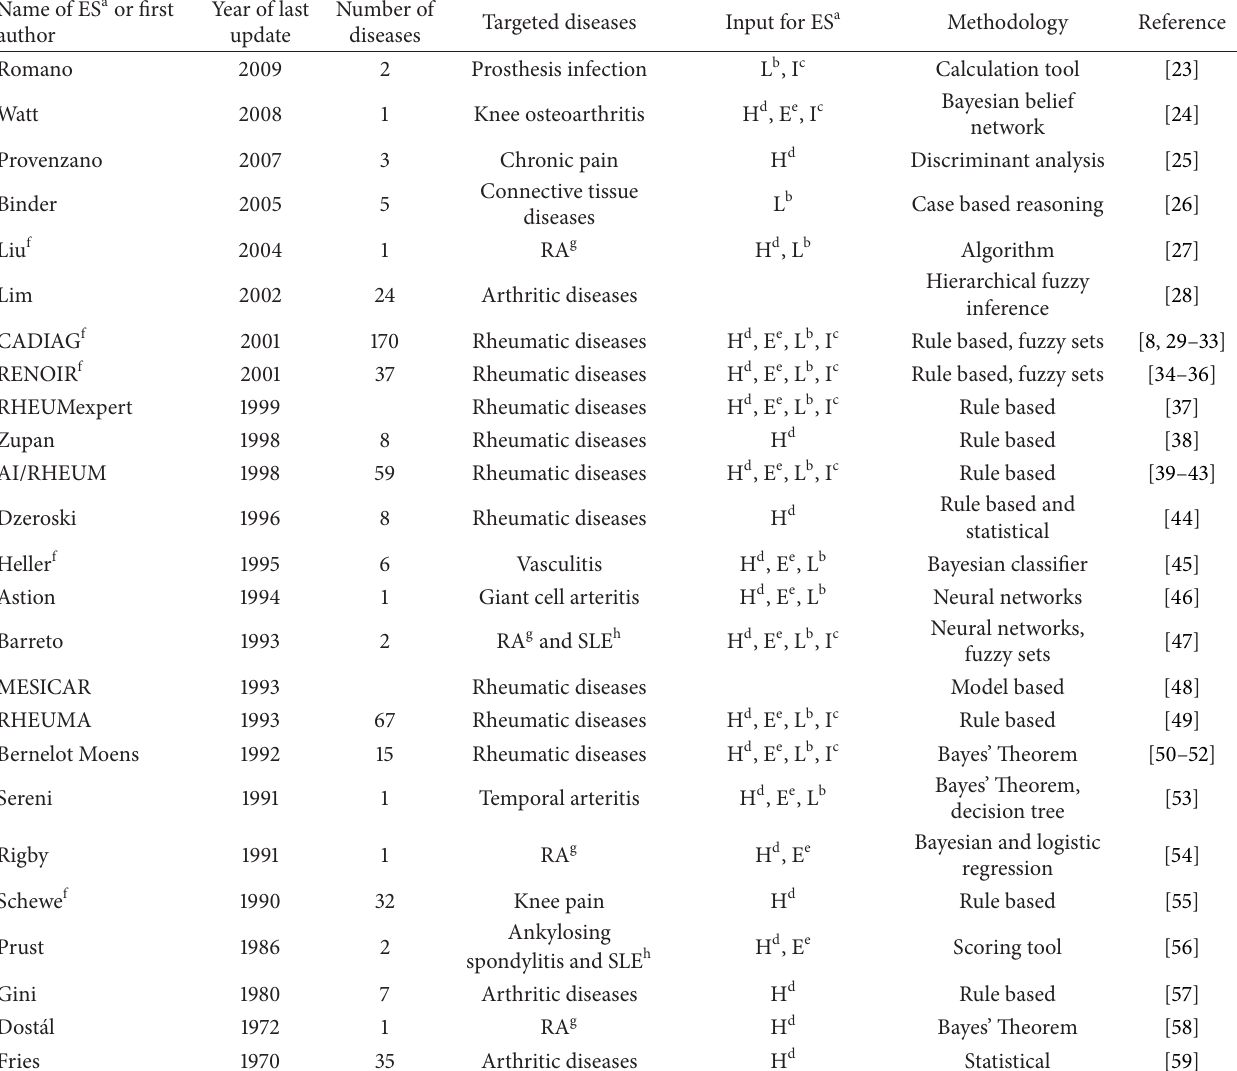
Table 1: Characteristics of the identified expert